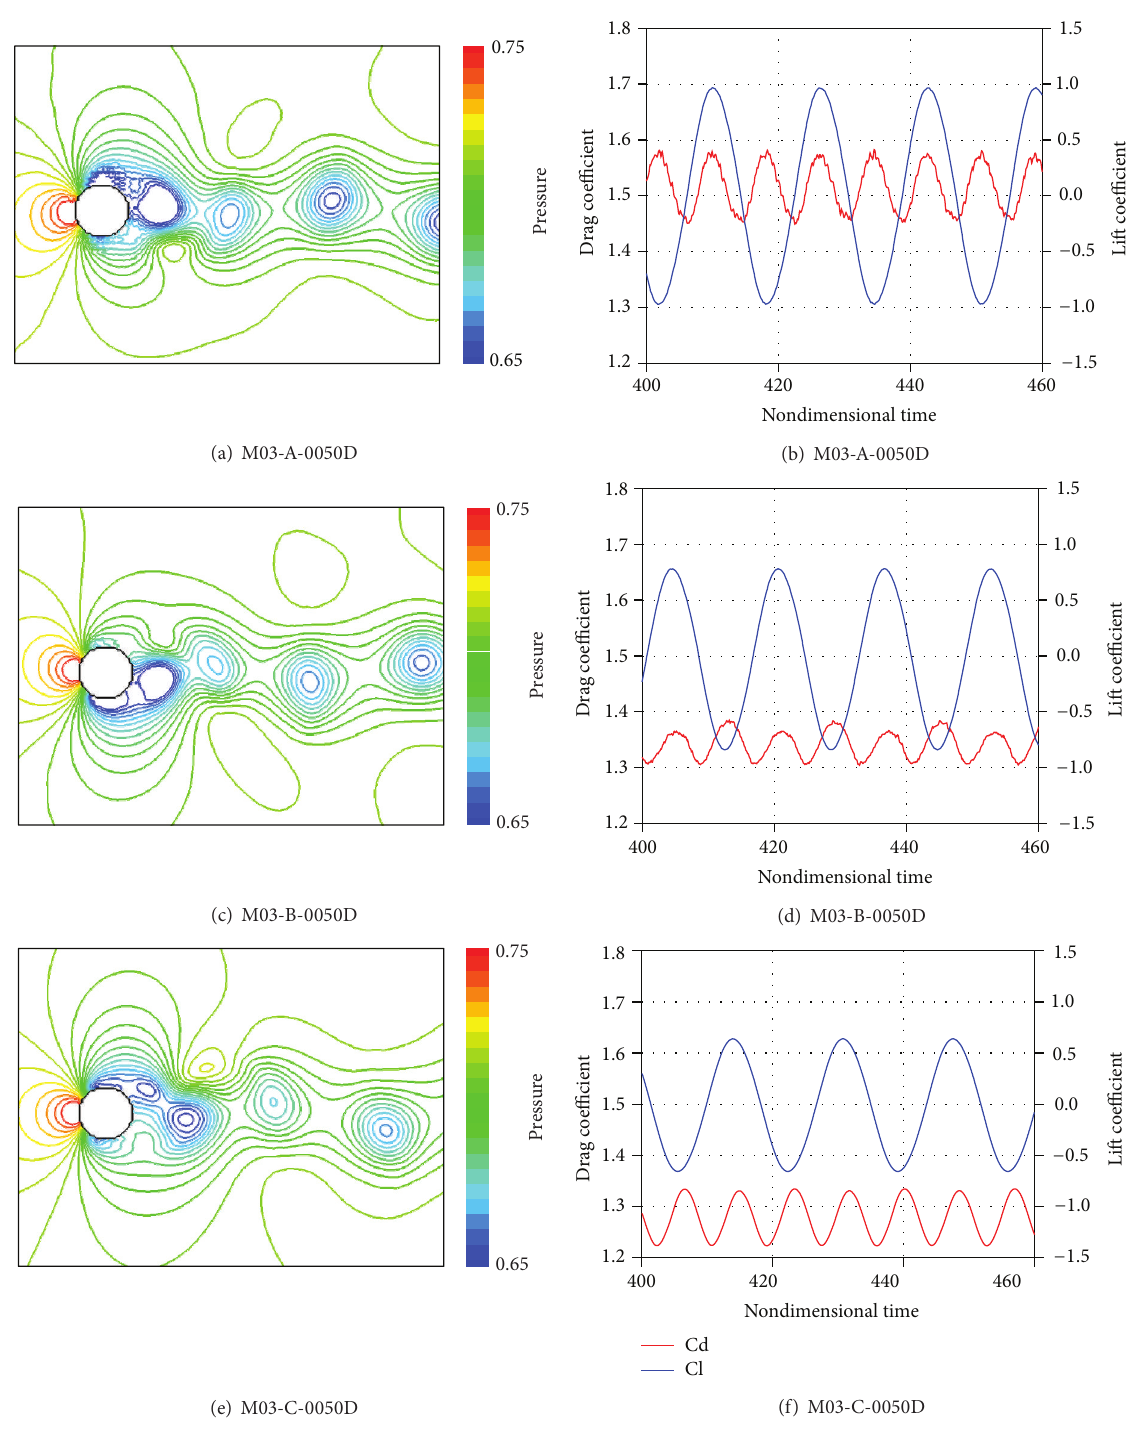
Figure 9: Pressure contours (left) and time variation of aerodynamic coefficient (right).